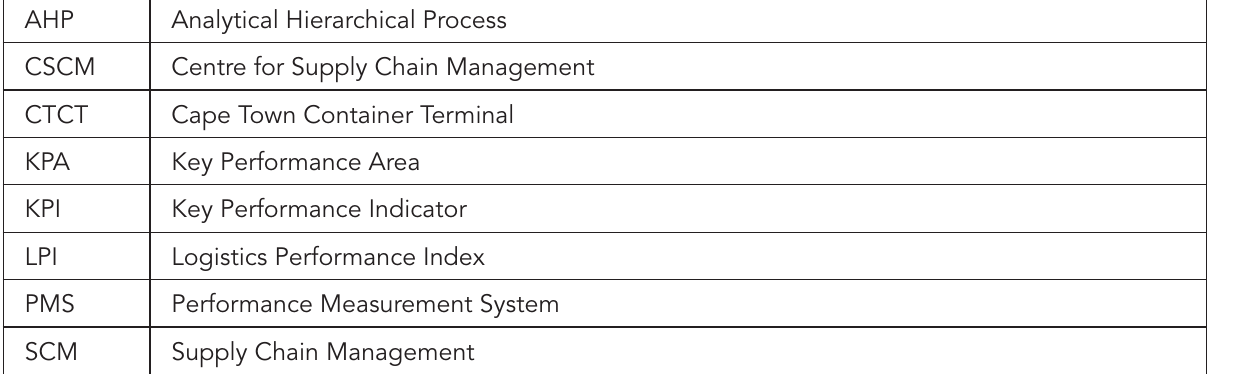
AHP Analytical Hierarchical